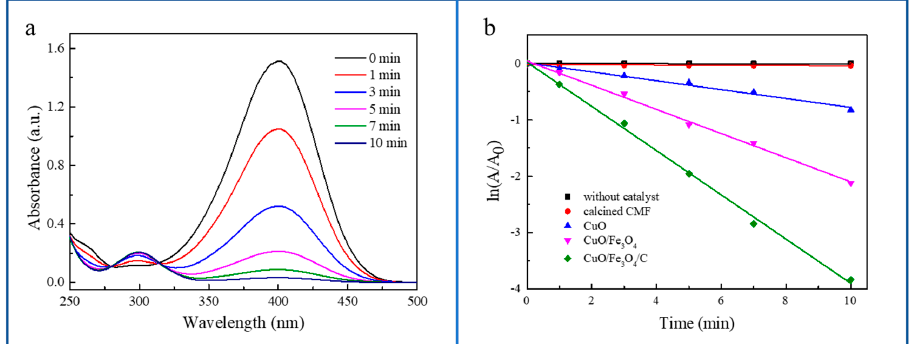
Figure 4. ( a ) Time-dependent ultraviolet–visible (UV–Vis) absorption spectra of 4-nitrophenol (4-NP) reduced by NaBH 4 in the presence of carbon-doped CuO/Fe 3 O 4 composite catalysts; ( b ) the first-order kinetic plot (absorbance at 400 nm, ln(A t /A 0 )) versus reaction time for the reduction of 4-nitrophenol; A t and A 0 represent the absorbance values of 4-NP at 400 nm at designated time t and t = 0, respectively.